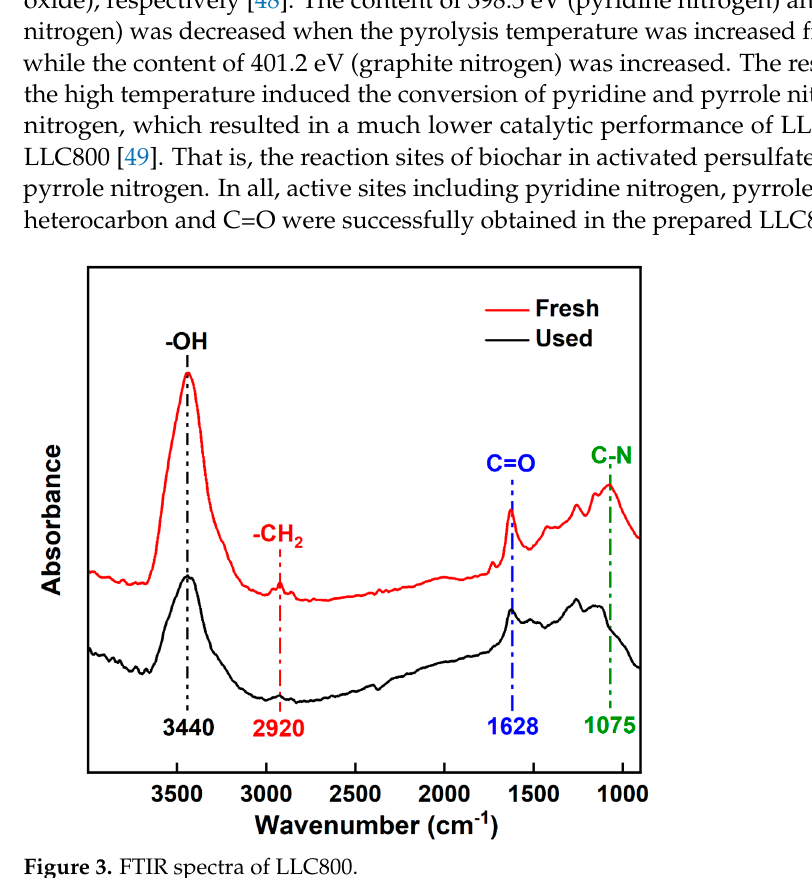
Figure 3. FTIR spectra of LLC800.